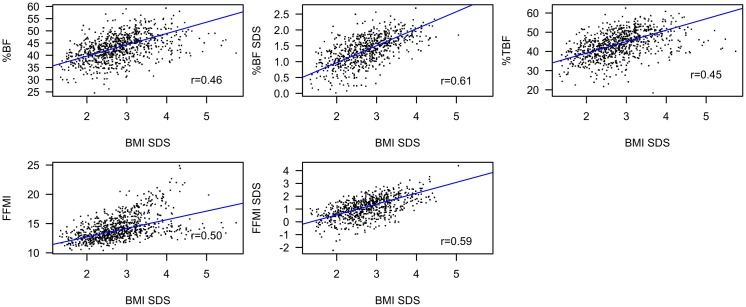
Baseline associations between BMI SDS and body composition variables.Plots of BMI SDS versus %BF SDS, %BF, %TBF, FFMI SDS, and FFMI at baseline. BMI: body mass index. SDS: standard deviation score. %BF: total body fat percentage. %TBF: truncal body fat percentage. FFMI: fat free mass index.